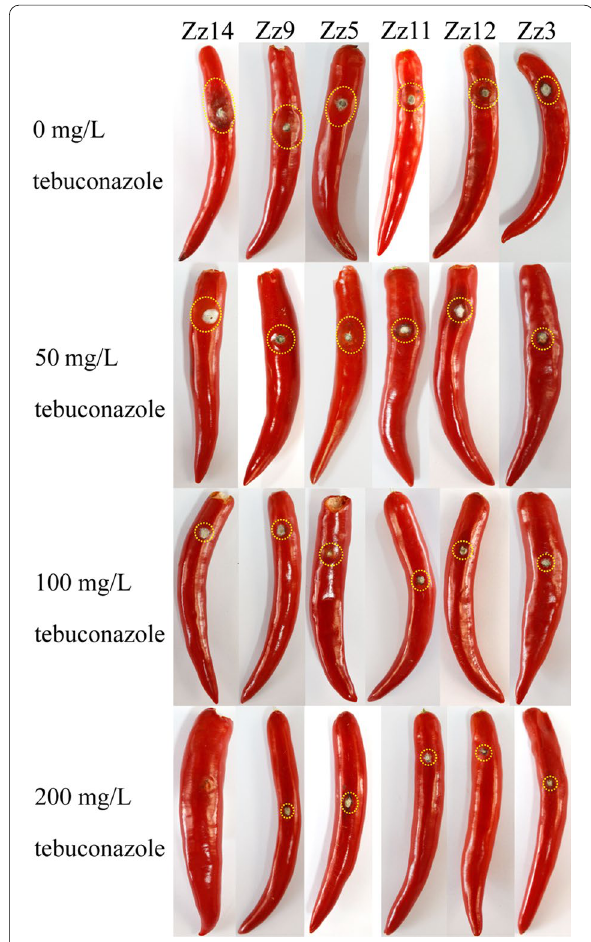
Fig. 6 Protective efficacy of tebuconazole against tebuconazole-sensitive and tebuconazole-resistant isolates of Colletotrichum siamense on chili fruits. The chili fruits were treated with water or different concentrations of tebuconazole for 24 h, and then were inoculated with mycelial plugs of tebuconazole-sensitive or tebuconazole-resistant isolates of C. siamense . Disease lesions were measured at 7 days